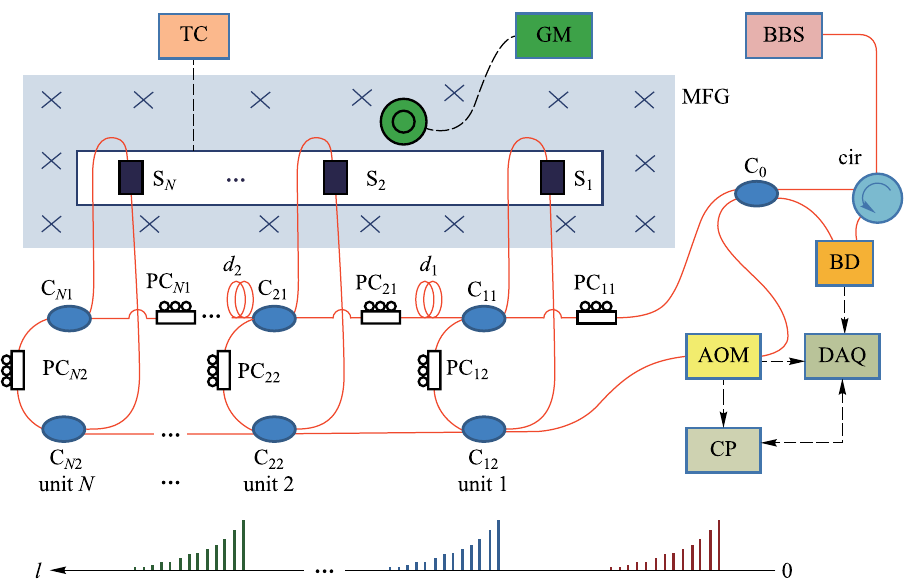
Table 2 Performance parameters of quasi-distributed magnetic sensors